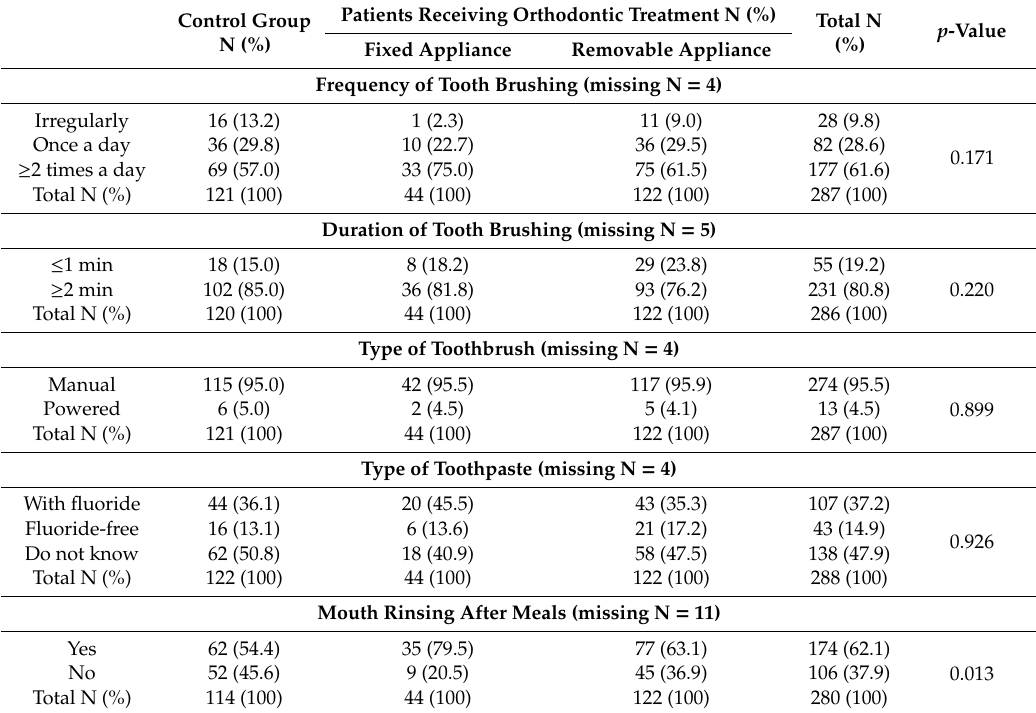
Table 2. Oral hygiene habits among participants visiting the Department of Orthodontics at Lithuanian University of Medical Sciences (LSMU)